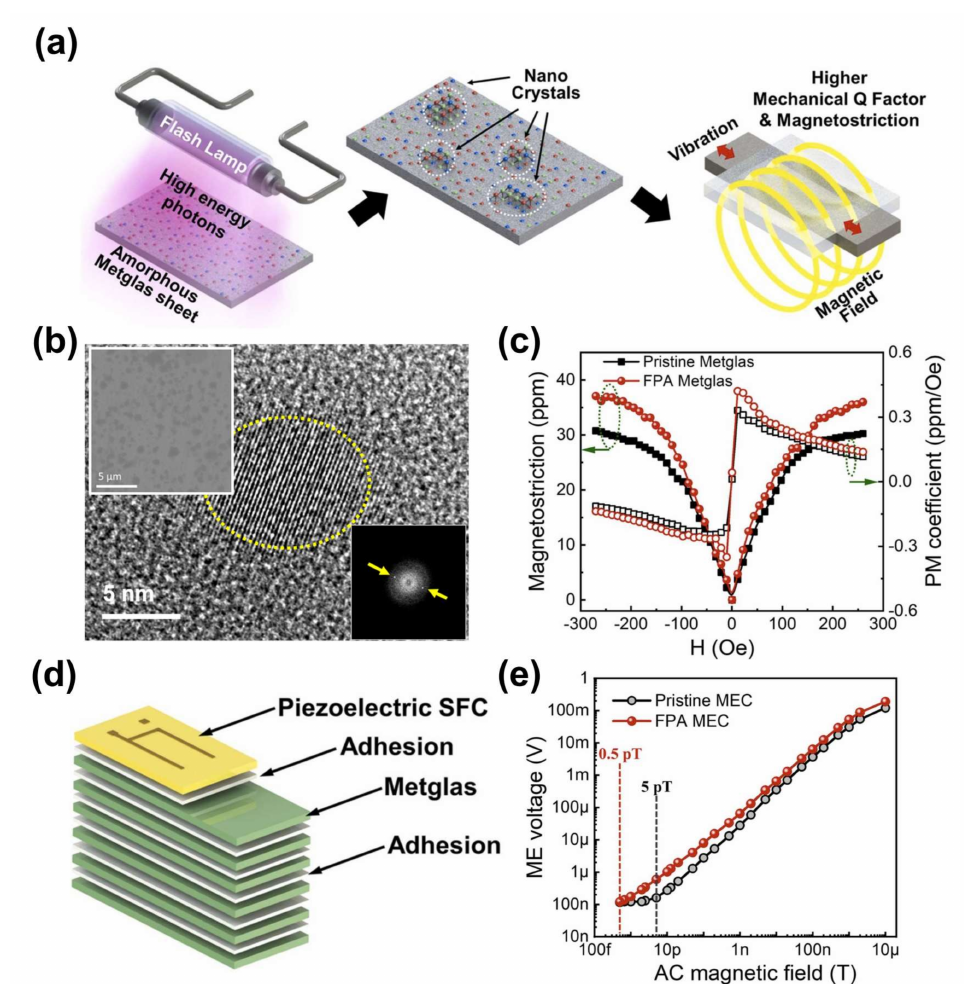
Figure 11. ( a ) Schematic illustration of the flash photon annealing process on Metglas sheet and the expected property enhancement. ( b ) Microstructure analysis results on Metglas surface after flash photon annealing. ( c ) Magnetostriction and piezomagnetic coefficient curves of flash annealed and pristine Metglas laminations. ( d ) Schematic illustration of the Metglas lamination-based MME magnetic field sensor. ( e ) Output voltage response signals of flash annealed and pristine MME sensors by applying AC magnetic field. Reproduced with permission